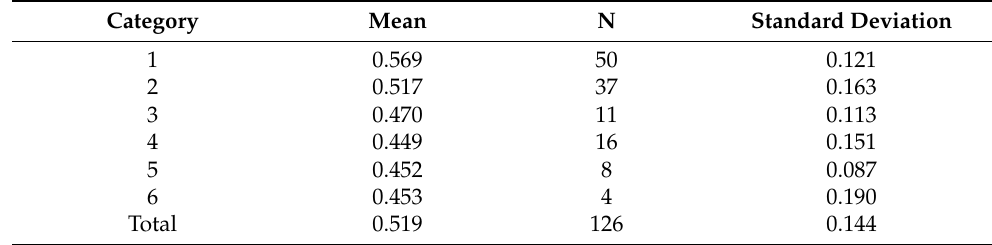
Table 8. Comparison of standard deviations of comprehensive accessibility of different